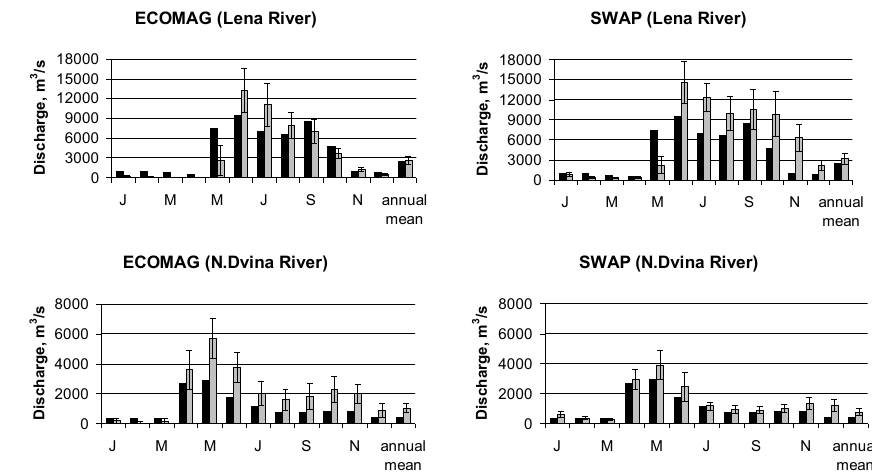
Figure 9. SD estimates of the annual and monthly discharges at the outlets of the Lena River (top panels) and the Northern Dvina River (bottom panels). Black columns show estimates obtained from the observational data for 1979–2009. Gray columns show estimates obtained from the ensemble simulation (with indicated 95% confidence intervals γ SD for these estimates).